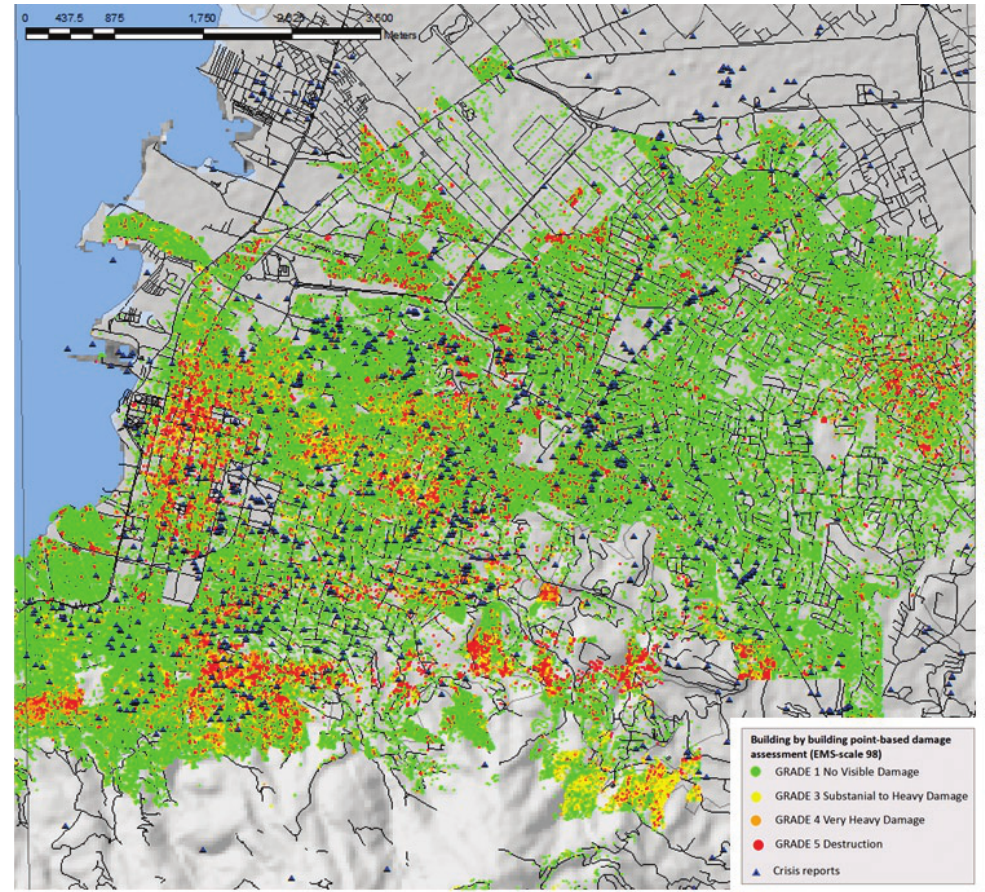
Fig. 3. Spatial distribution of building damage and crisis reports within the observation window of approximately 9 ×